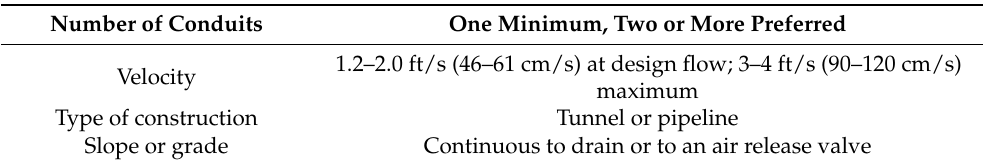
Table 1. Intake conduit design criteria [19] .